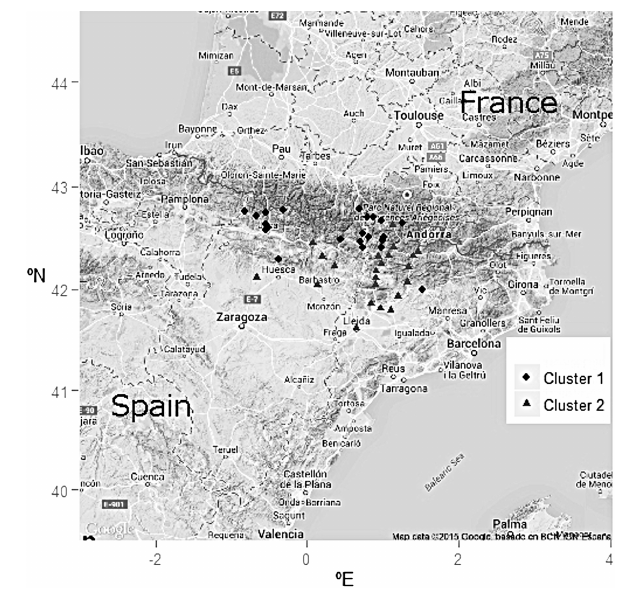
Figure 1. Location of the study area and stations in cluster 1 (black circles) and cluster 2 (grey triangles) using RGoogleMaps package (Kilibarda and Bajat, 2012).